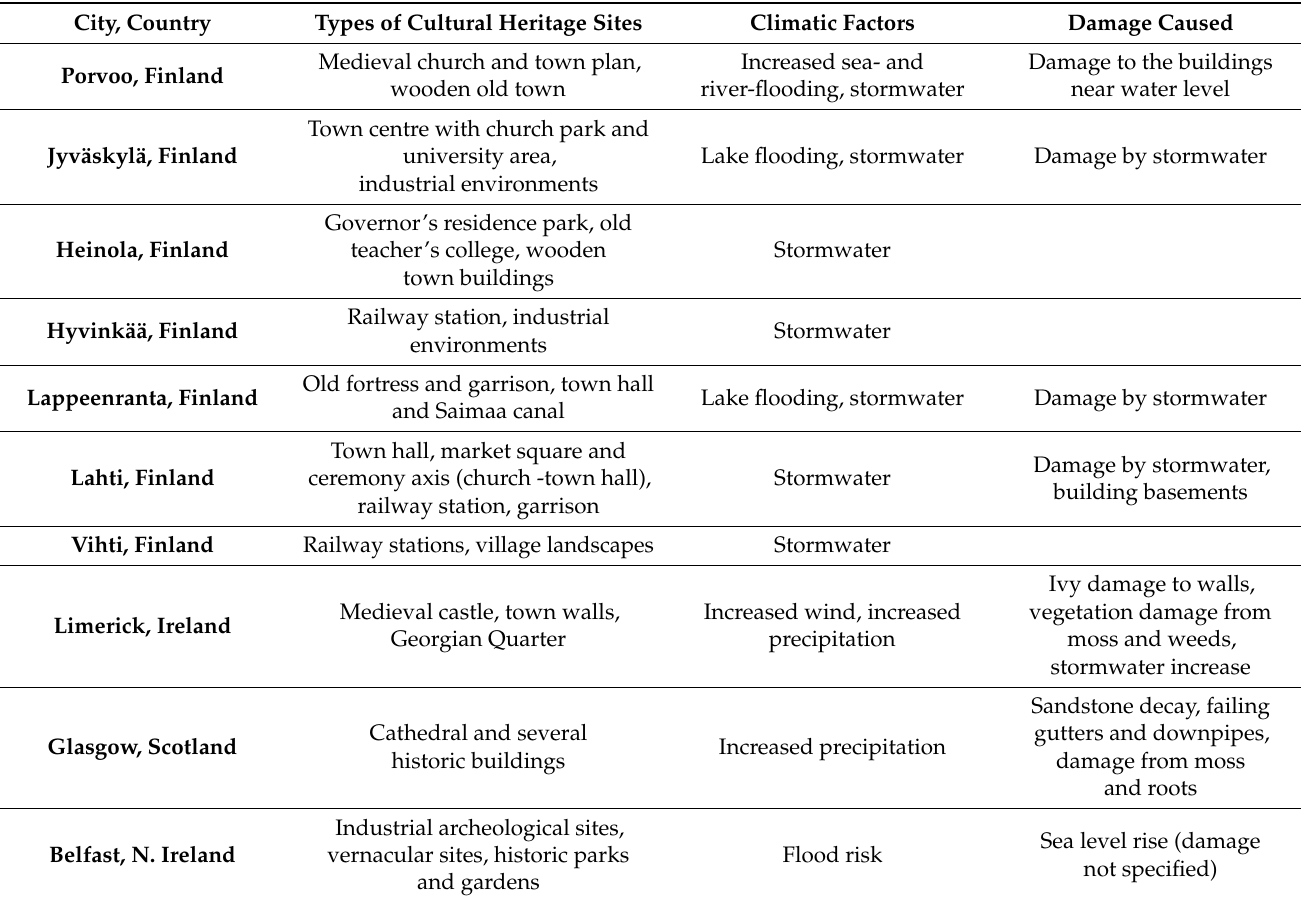
Table 4. Details of relevant cultural heritage and threats. This table introduces the target cities which the respondents represent, as well as the characteristics of the cultural heritage in each city. Additionally, the table summarises the observations of the respondents dealing with climate change impacts and damage in their city